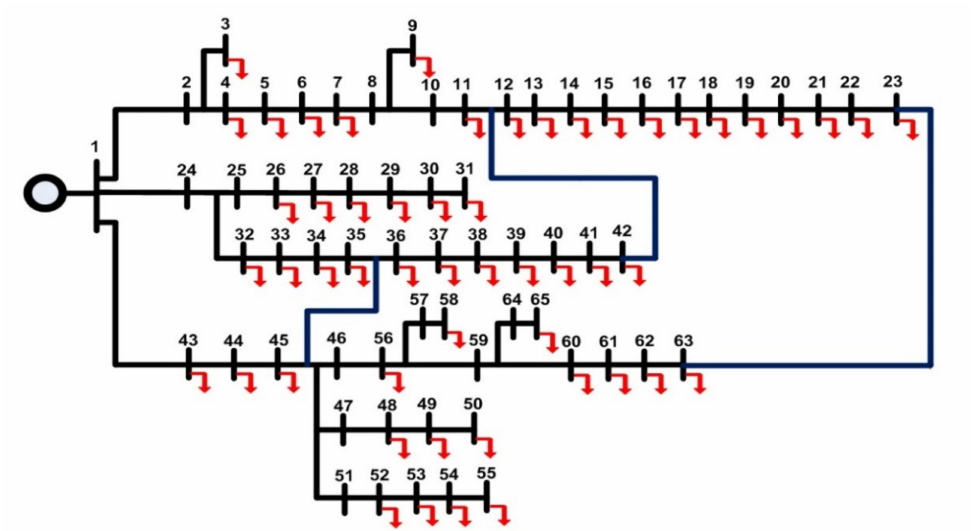
Figure 4. Actual NUST mesh-configured 65-bus microgrid (MCMG).